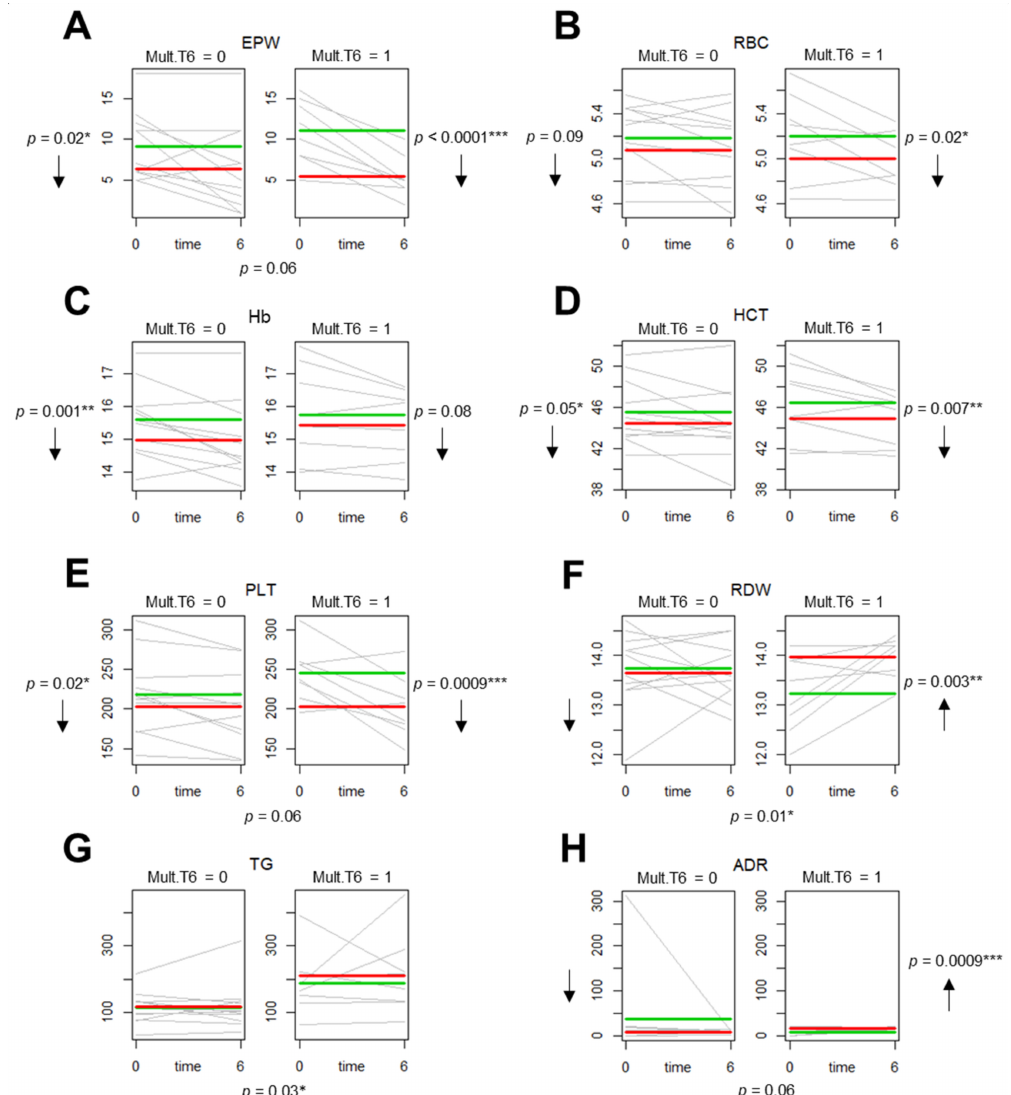
Figure 5. Spaghetti plot displaying clinical parameter data evaluated in two subgroups of OSA patients before (t0) and after six months of PAP treatment (t6). The OSA subgroup with (pred.mult = 1) and without (pred.mut = 0) induced PRDX2 SO 2 / 3 multimer after six months of PAP treatment were compared by evaluating the clinical parameters under study at time t0 and t6, using Logistic GEE regression models. The most significant data were obtained for EPW ( A ), RBC ( B ), Hb ( C ), HCT ( D ), PLT ( E ), RDW ( F ), TG ( G ) and ADR ( H ) clinical parameters as shown. Green line indicates the average value of a clinical parameter at t0, and the red line indicates the average value of this clinical parameter at time